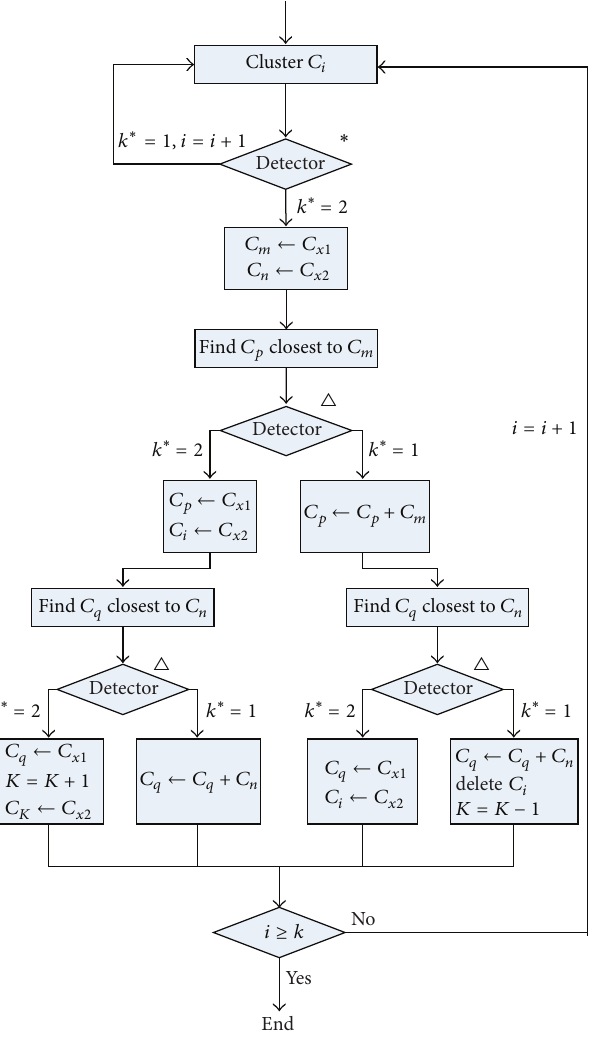
Figure 9: The flowchart of